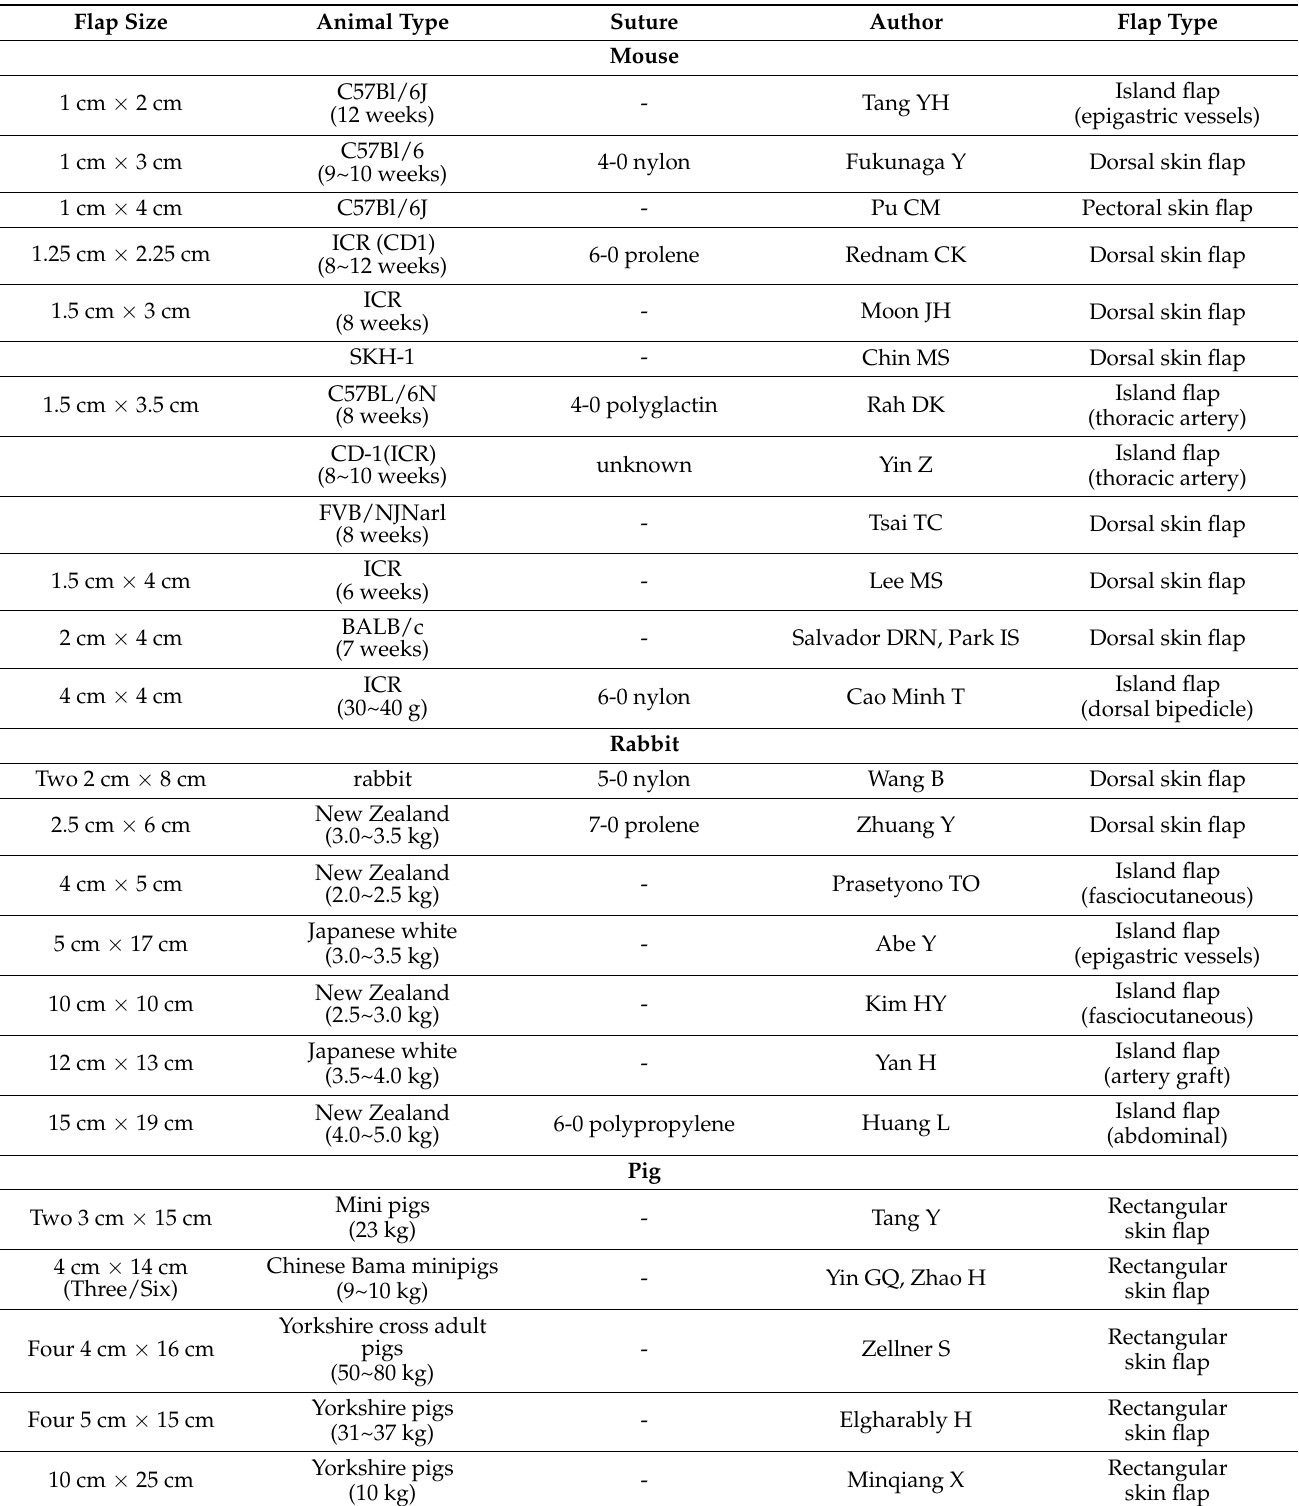
Table 2. Skin flap mouse and big animal models: flap sizes and